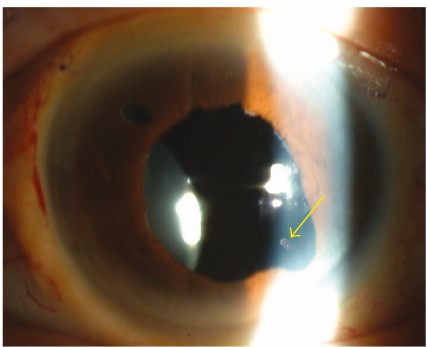
Figure 1: Separation between the haptic and optic in an eye with a dislocated intraocular lens. The patient was aware of the sudden decrease of vision in his left eye which had undergone repositioning of an in-the-bag dislocated IOL using the intrascleral haptics fi xation technique two weeks earlier. Note that the optic has shifted nasally and the end of the haptic formerly inserted into optic can be seen